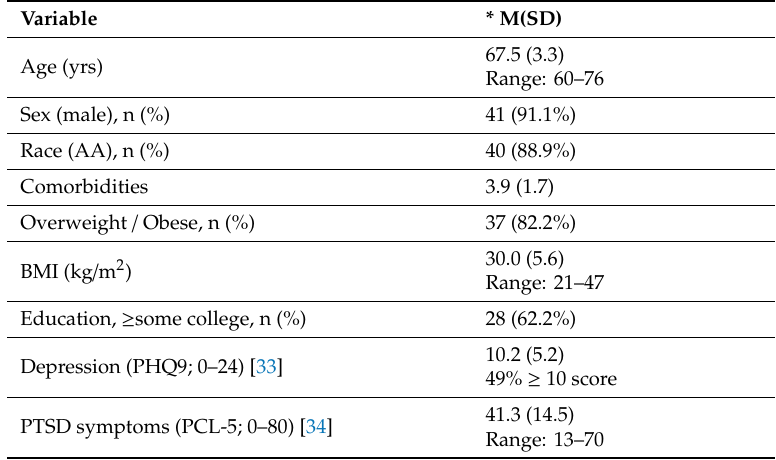
Table 1. Participant Characteristics ( N =